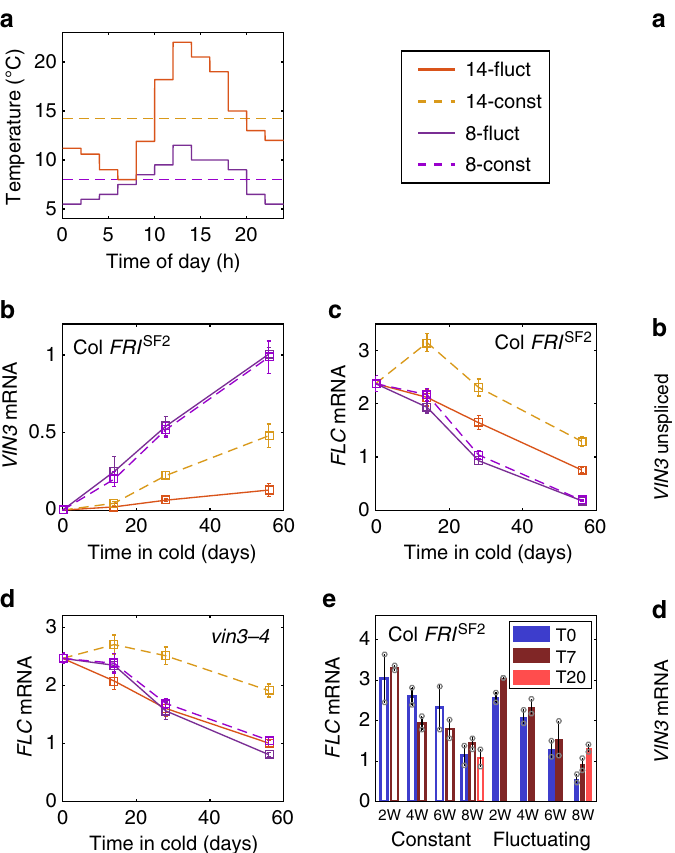
Fig. 3 Modelling VIN3 dynamics reveals its temperature inputs. a Minimal model of VIN3 temperature sensing assuming a single thermosensor r whose levels quantitatively regulate VIN3 transcription. p 1 = 0.91 day − 1 , d 1 = 100 day − 1 , d 2 = 7 day − 1 . See Methods for more details. b Slow VIN3 upregulation in the cold for unspliced RNA, sampled 5 – 7 h after dawn. n = 3 – 6, average > 4.7. c , d VIN3 unspliced and spliced RNA levels upon return to warm (22 °C) following 4 weeks at 5 °C. At time 0, plants were sampled in the cold and subsequently transferred to warm. n = 2 – 3, average > 2.6. e Slow VIN3 mRNA upregulation in the cold, sampled 5 – 7 h after dawn. Colours correspond to vernalisation treatment as shown in legend to b . n = 3 – 6, average = 5. Model results shown in d , e . In b − e , RNA levels were normalised to UBC , PP2A ; error bars =